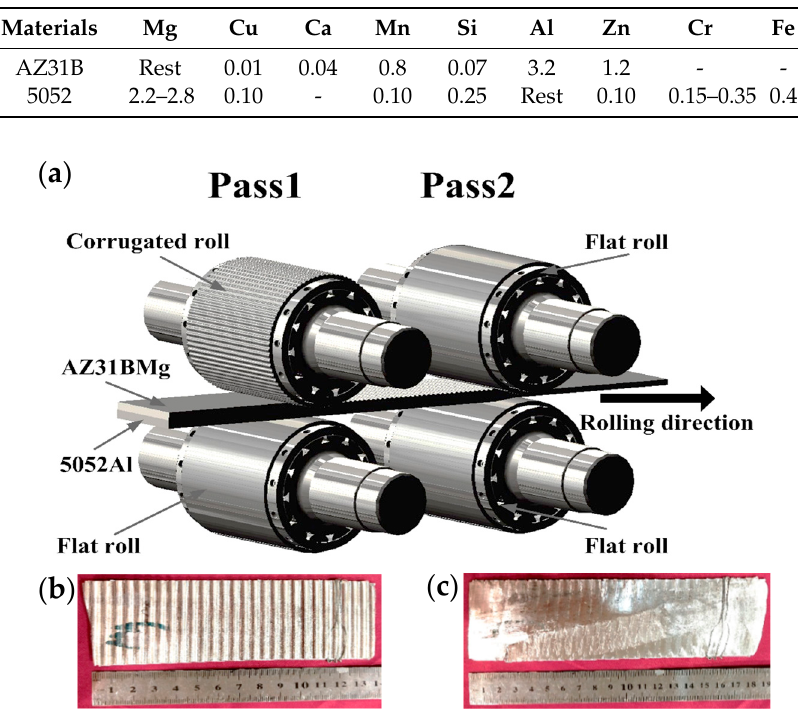
Figure 1. Schematic diagram of the CFR method and actual Mg/Al laminated composite: ( a ) Schematic diagram of the CFR method; ( b ) the corrugated sample after the first CFR pass; and ( c ) the flattened composite after the second CFR pass.